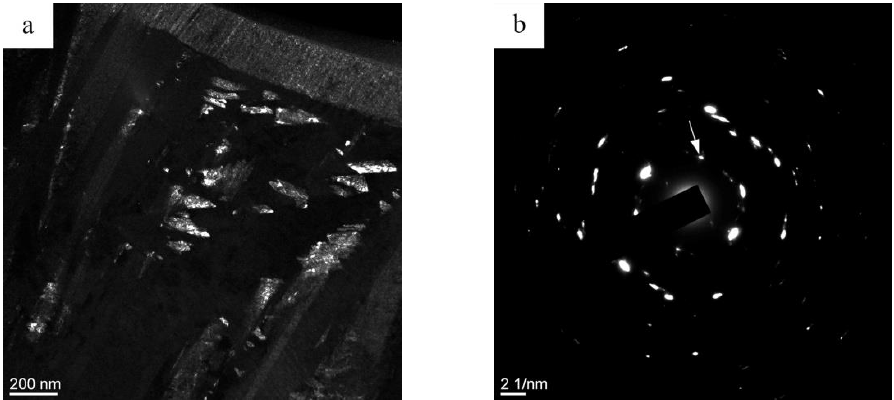
Figure 5. Microstructure of surface layer 2 of the EBM Ti-6Al-4V samples after PIB irradiation: dark-field image in the (220) α”-Ti reflection (indicated by an arrow in Figure 2b) ( a ), and microdiffraction ( b ).